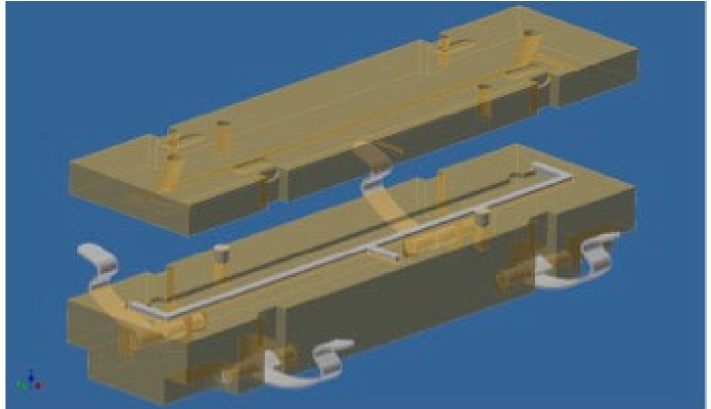
Figure 1. Custom-made casting chamber for fabrication of tendon-like